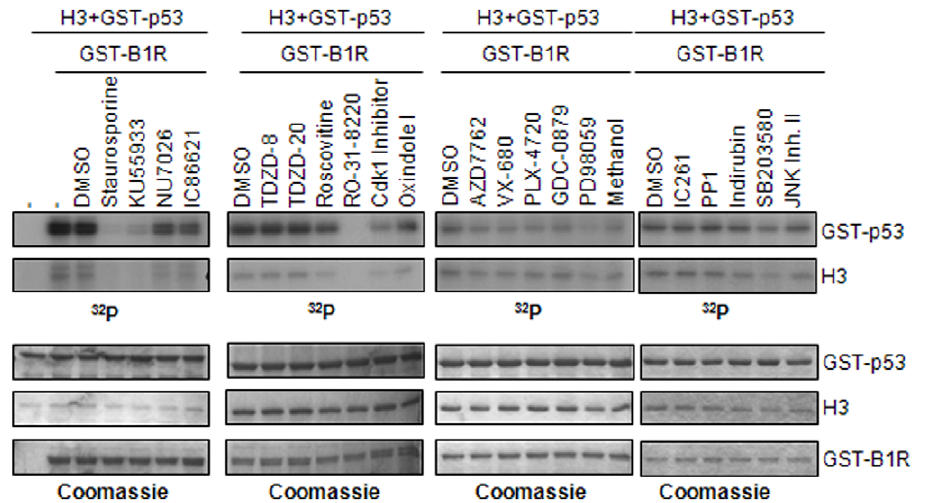
Figure 4. Inhibition of vaccinia virus B1R kinase. Phosphorylation assays were performed using 1 m g of purified GST-p53 or Histone H3 as substrates. Quantification was performed in the linear response